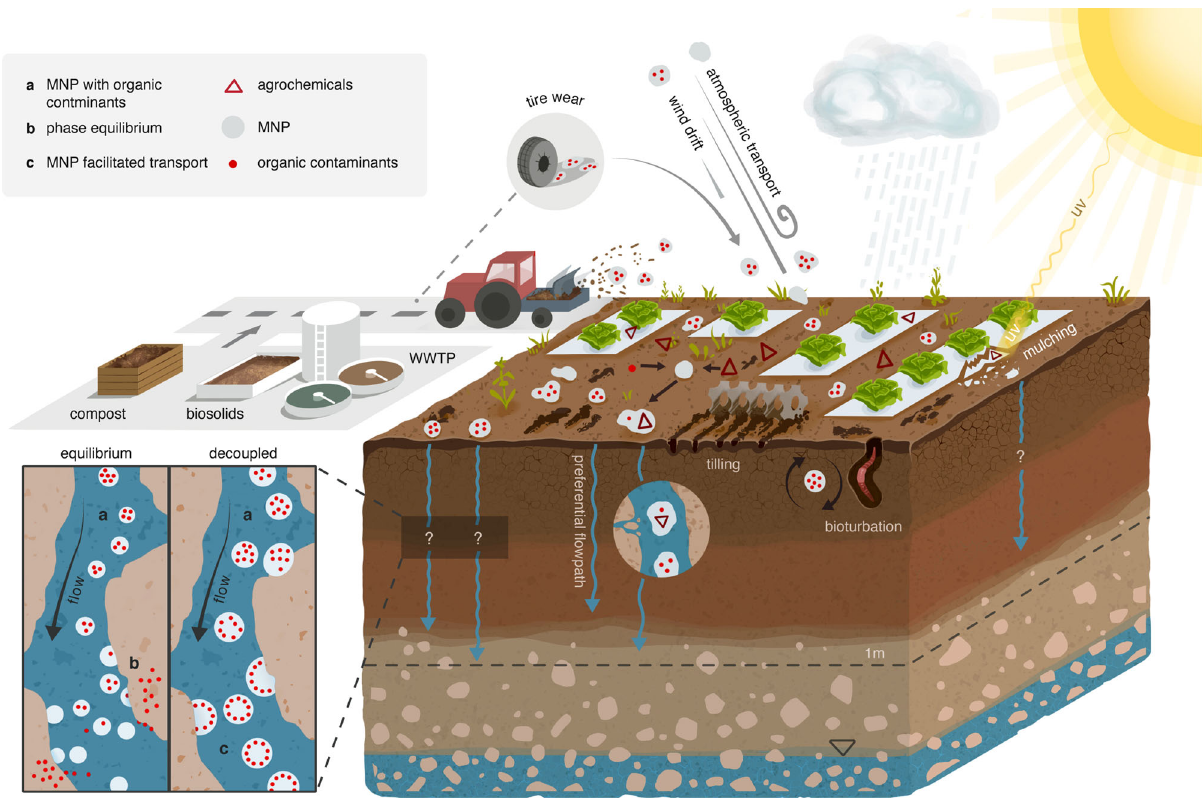
Fig. 1 Pathways and sources of micro- and nanoplastics (MNP) and organic contaminants in farmland soils. Atmospheric input, tire wear, and common agricultural practices like the application of compost, biosolids from waste water treatment plants (WWTP), or mulching introduce MNP and organic contaminants to the soil. Physical and chemical degradation of plastics, e.g., by UV irradiation causes their fragmentation to MNP. Bioturbation, tilling or preferential fl ow paths enhance vertical transport of MNP. a MNP containing organic contaminants are suspected to vertically relocate them towards the groundwater table. b If contaminants are in equilibrium, MNP do not enhance contaminant relocation; c if the transport is decoupled, no signi fi cant desorption of contaminants occurs during transport and MNP facilitate as vector their relocation. Establishing equilibrium of contaminants with plastics and all soil phases is faster for smaller MNP than for larger